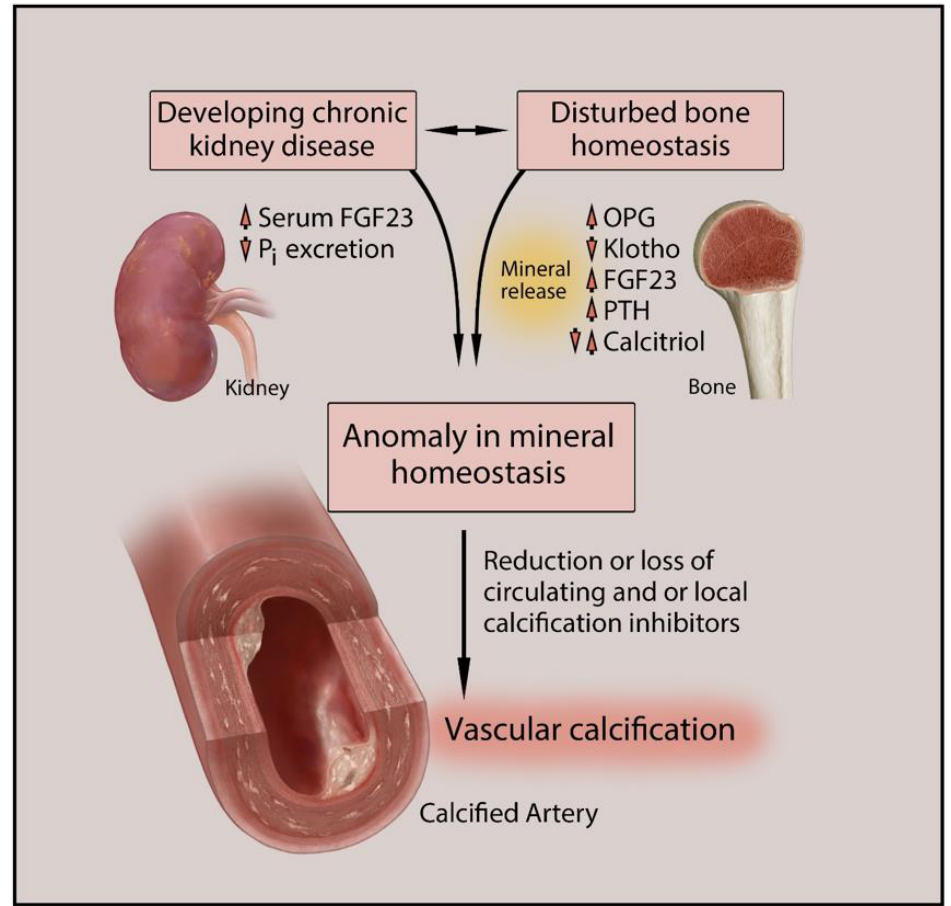
Figure 1. Pathogenesis of vascular calcification in chronic kidney disease (CKD). Altered bone metabolism and mineral homeostasis are commonly found and closely interconnected in CKD patients. The decline in kidney function also leads to elevated serum FGF23 levels and reduced inorganic phosphate excretion. The resulting pathological state is reflected by various altered biomarkers such as OPG, Klotho, PTH, and calcitriol. The disturbed mineral homeostasis also leads to altered serum and tissue levels of Ca, Pi, and Mg causing inflammation and other metabolic disorders. This leads to reduced or complete loss of circulating and/or local calcification inhibitors such as fetuin A, PPi, and MGP, causing vascular calcification. Ca, calcium; FGF23, fibroblast growth factor 23; Mg, magnesium; MGP, matrix Gla protein; OPG, osteoprotegerin; Pi, inorganic phosphate; PPi, inorganic pyrophosphate; PTH, parathyroid hormone. Upper arrow, increase; lower arrow, decrease.